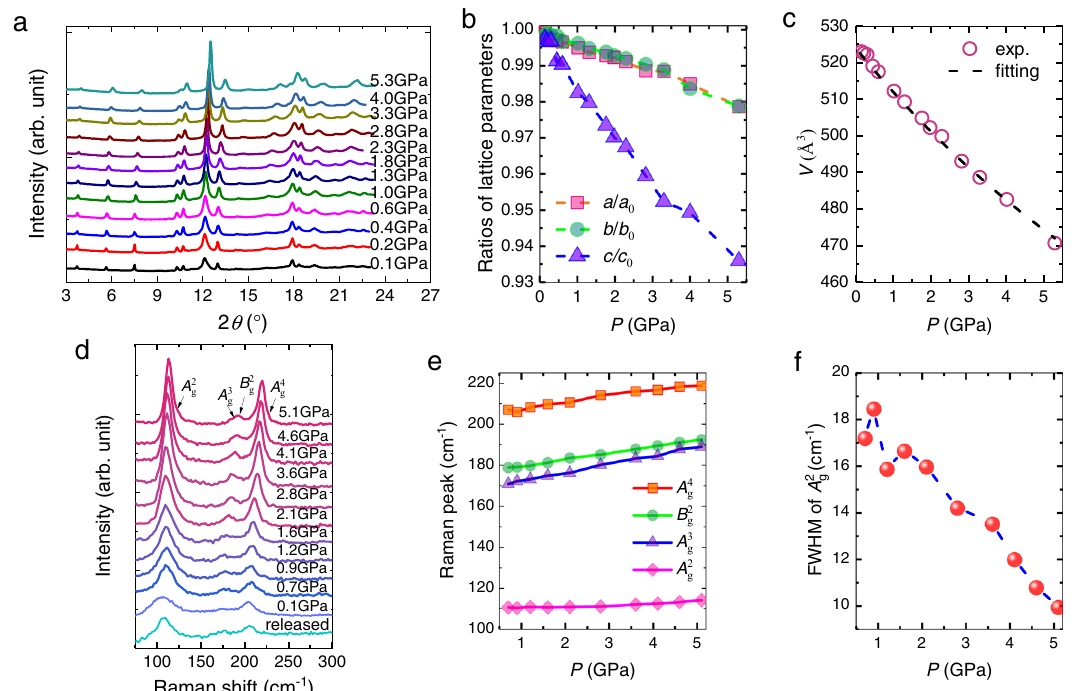
Fig. 2 | X-ray diffraction (XRD) and Raman measurements of β ′ -In 2 Se 3 . a SynchrotronXRD spectraatdifferentpressures. b Normalizedcompressionratio of a , b , and c axis. c Volume evolution with pressure extracted from XRD spectra. The black dashedline isa fi t to the third-order Birch-Murnaghan equation of state, as described in the main text. d Raman spectra at different pressures. e Wave